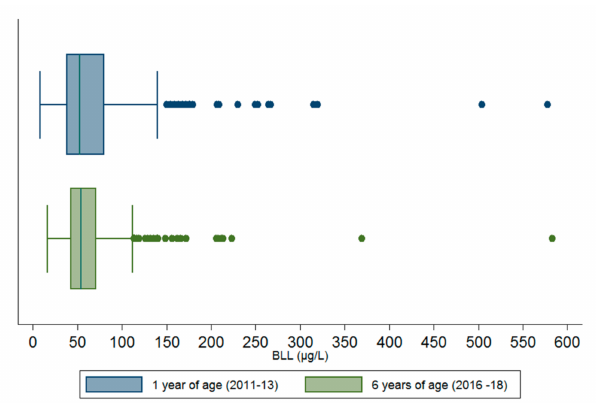
Figure 2. Comparison of blood lead level distribution in 2011–2013 and 2016–2018 ( n = 425).